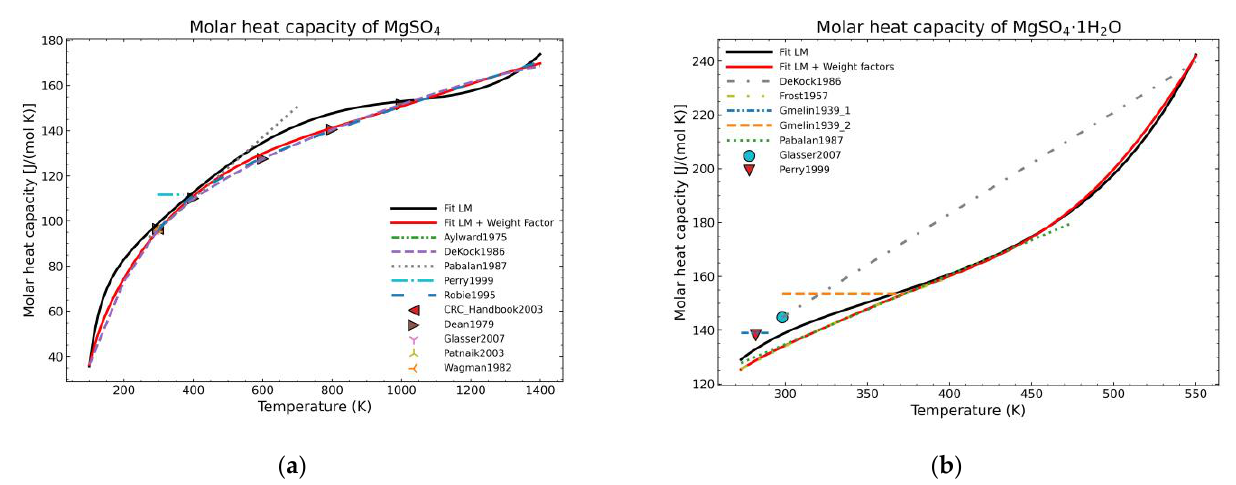
Figure 2. Comparison of fit results from a standard LM-algorithm and the addition of weight factors (red) for: ( a ) Anhydrous magnesium sulfate; ( b ) magnesium sulfate monohydrate.